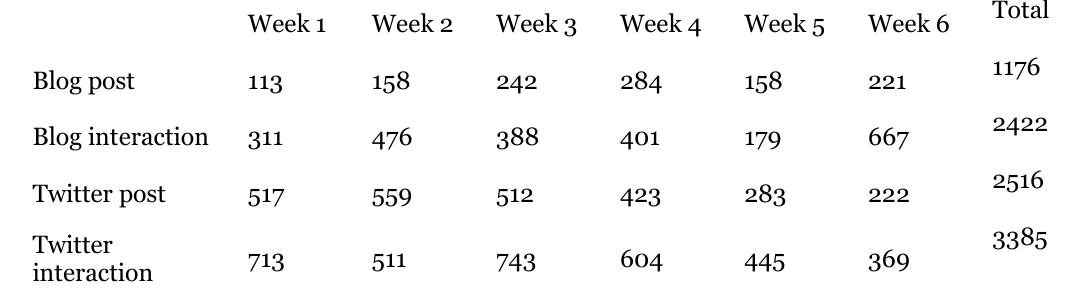
The Number of Posts and Interactions Generated in Different Spaces Each Week Week